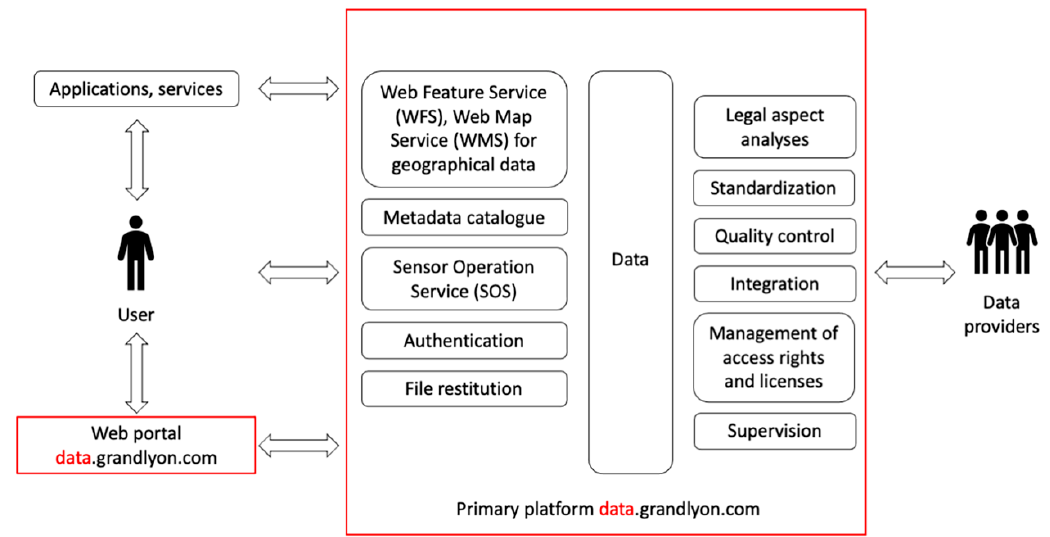
Figure 1. Overview of Grand Lyon’s Smart Data Platform (SDP) that was expanded to include data from La Confluence within the Smarter Together (ST) project.